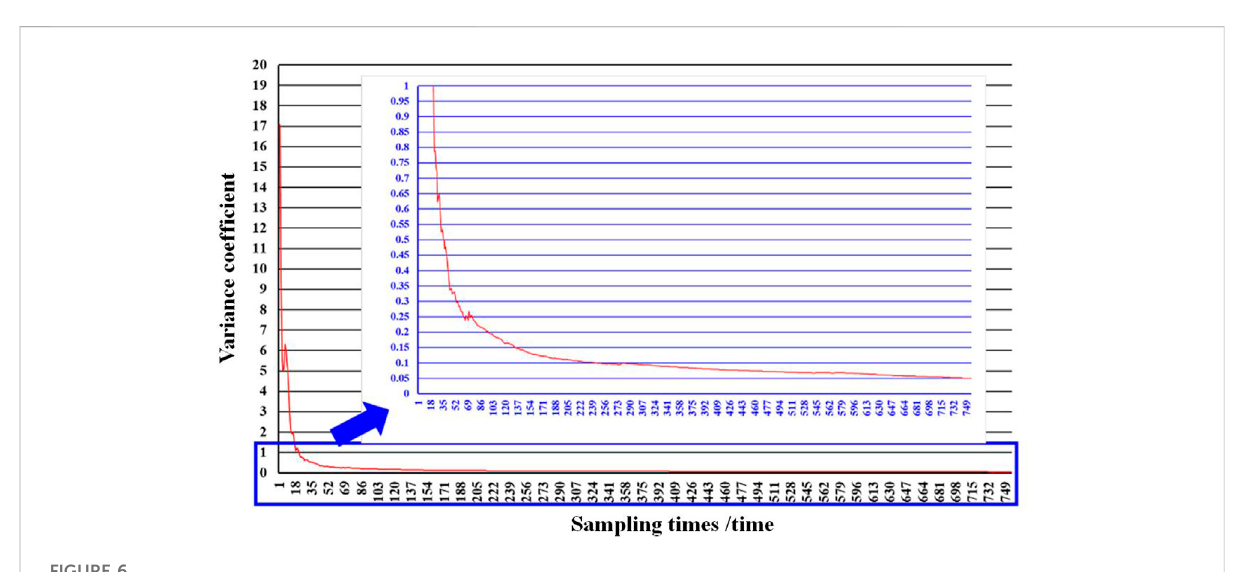
FIGURE 6 The diagram of the SMCS convergence